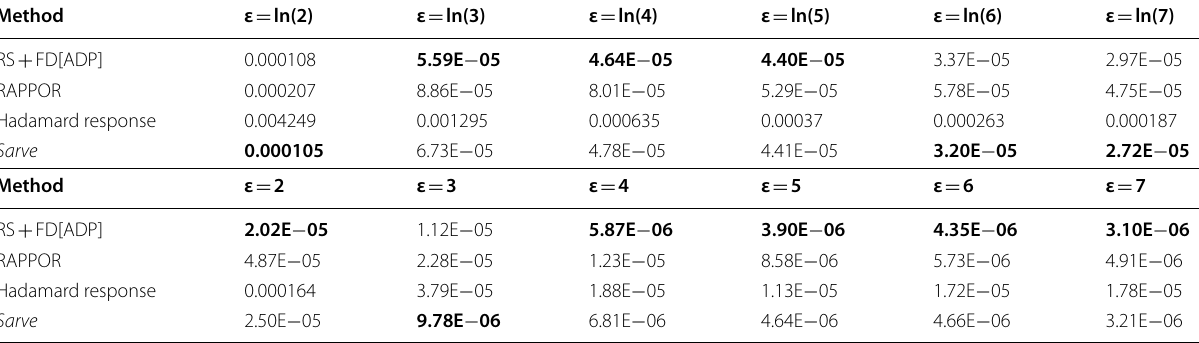
The values in bold indicate privacy conditions when Sarve performed better than adaptive RS estimated